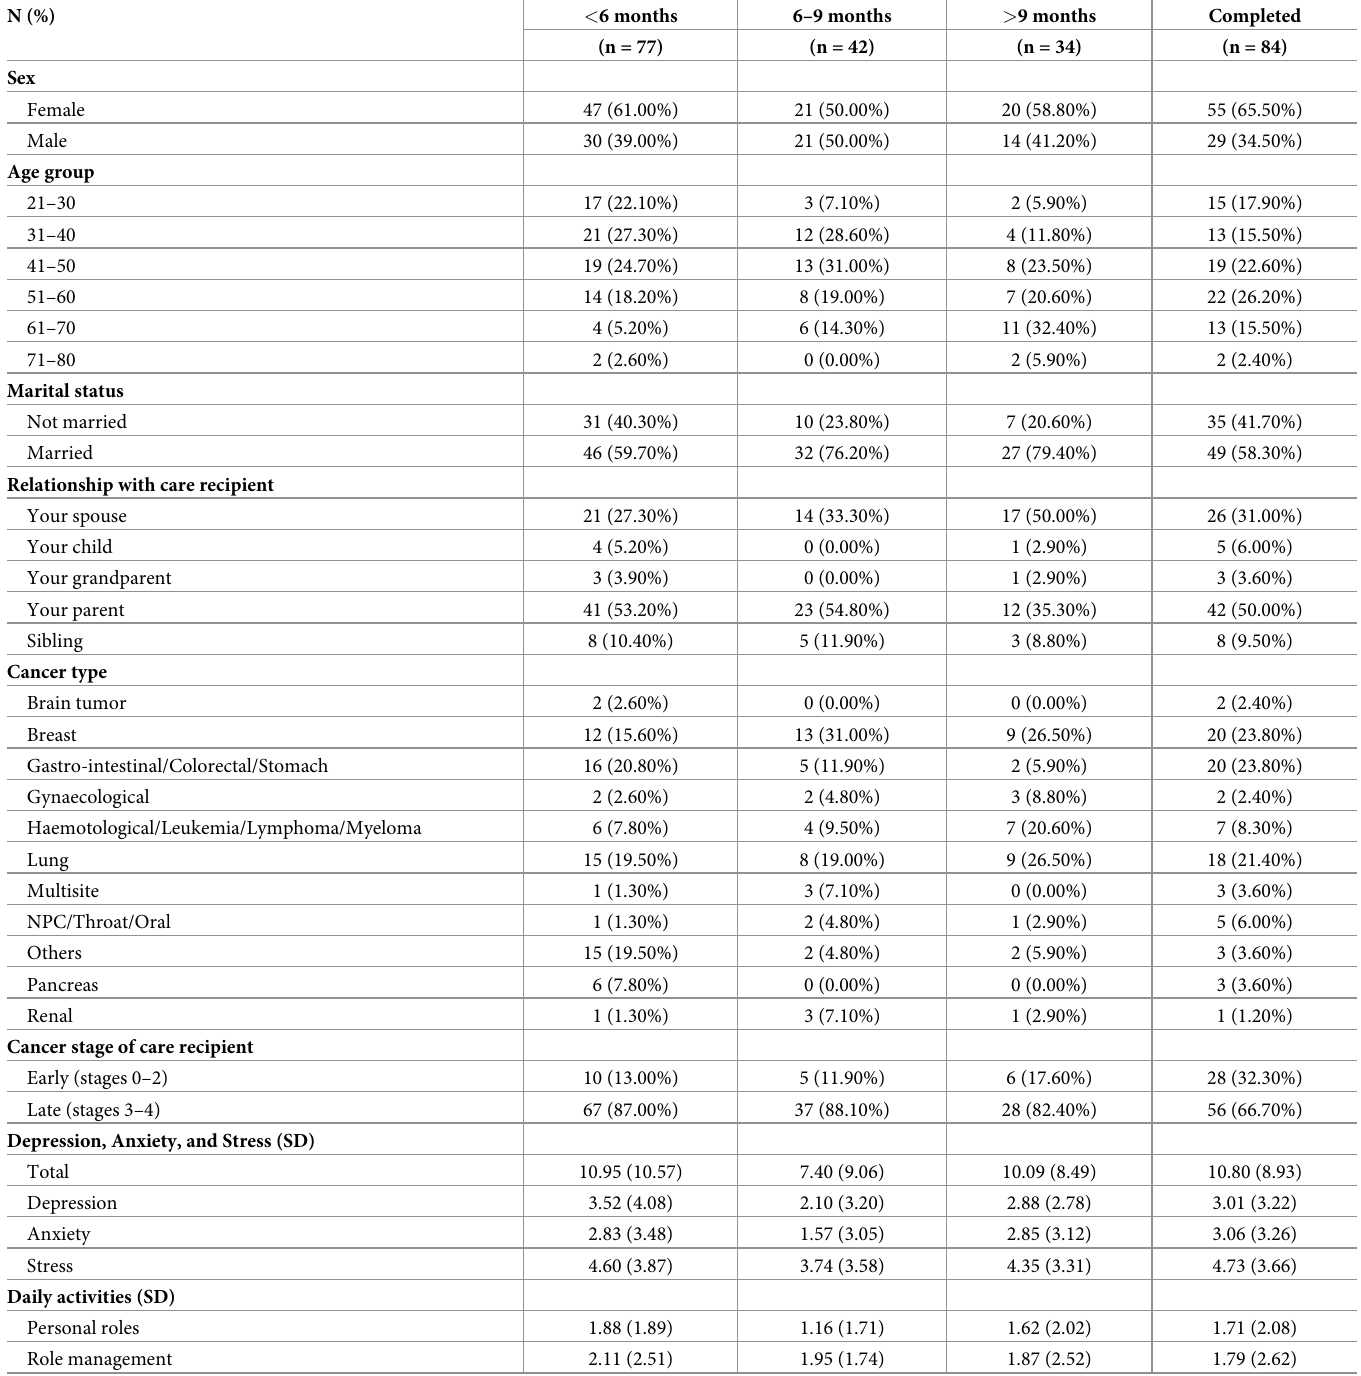
Table 1. Participants demographics from different treatment